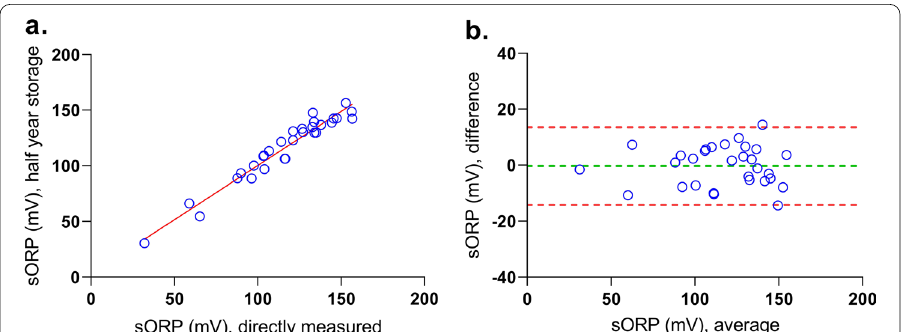
Fig. 1 Correlation (left) and Bland–Altman (right) plot. a The X ‑axis represents the sORP results of direct measurements and the Y ‑axis represents the stored samples ( R 2 linear average sORP of the direct and half year measurements. The Y ‑axis represents the difference of the two measurements. The mean bias (green line) and its confidence limits (limits of agreement) (red lines) are shown